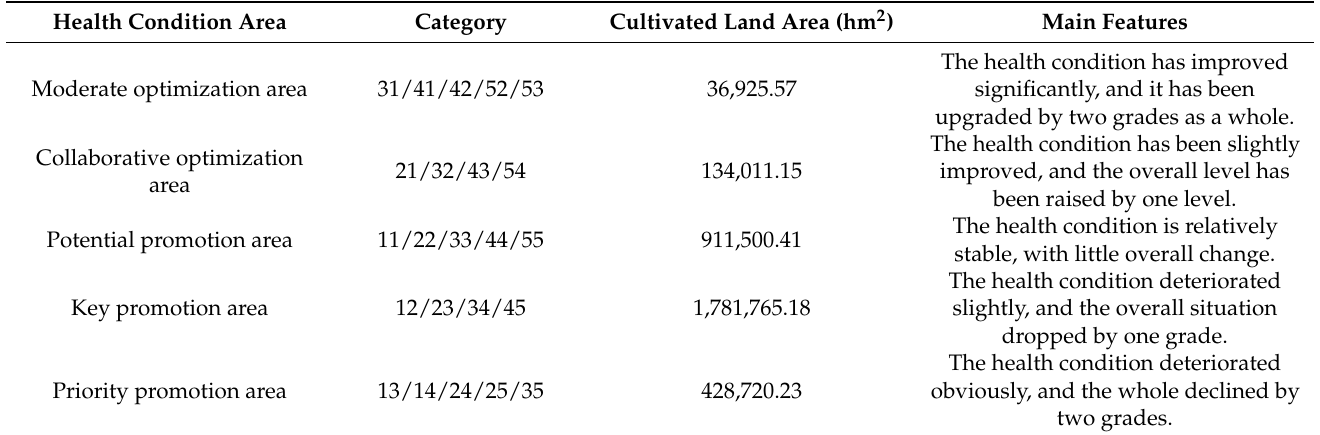
Table 7. Zoning methods and characteristics of health